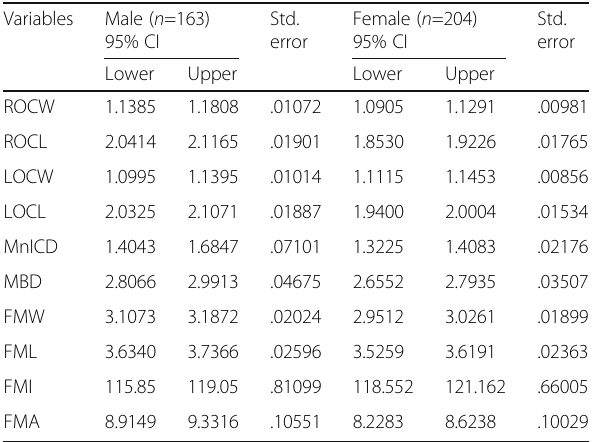
Table 2 Mean differences of the craniometric parameters of foramen magnum and occipital condyles between males and females among the studied Egyptian population ( n =367) Variables